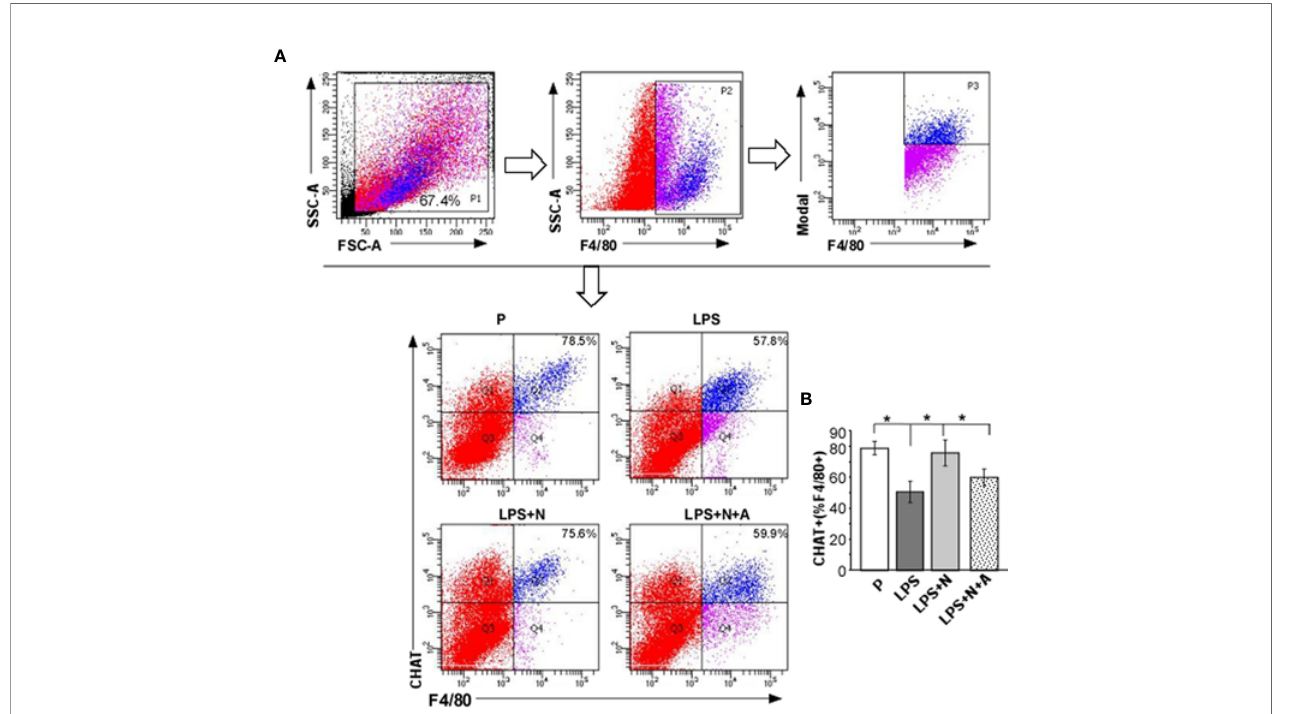
FIGURE 7 | Nicotine upregulated the decreased a 7nAChR activity (CHAT expression) on dM j from LPS-induced PE-like mice. (A, B) Percentages of CHAT + dM j in all experimental groups were calculated by fl ow cytometric analysis. Total leukocytes were gated using FSC vs. SSC and then gated for identifying CD68 + macrophages. Representative data were derived from separate mice in each group. Data are presented as means ± SEM of 10 pregnant mice per group. *P <